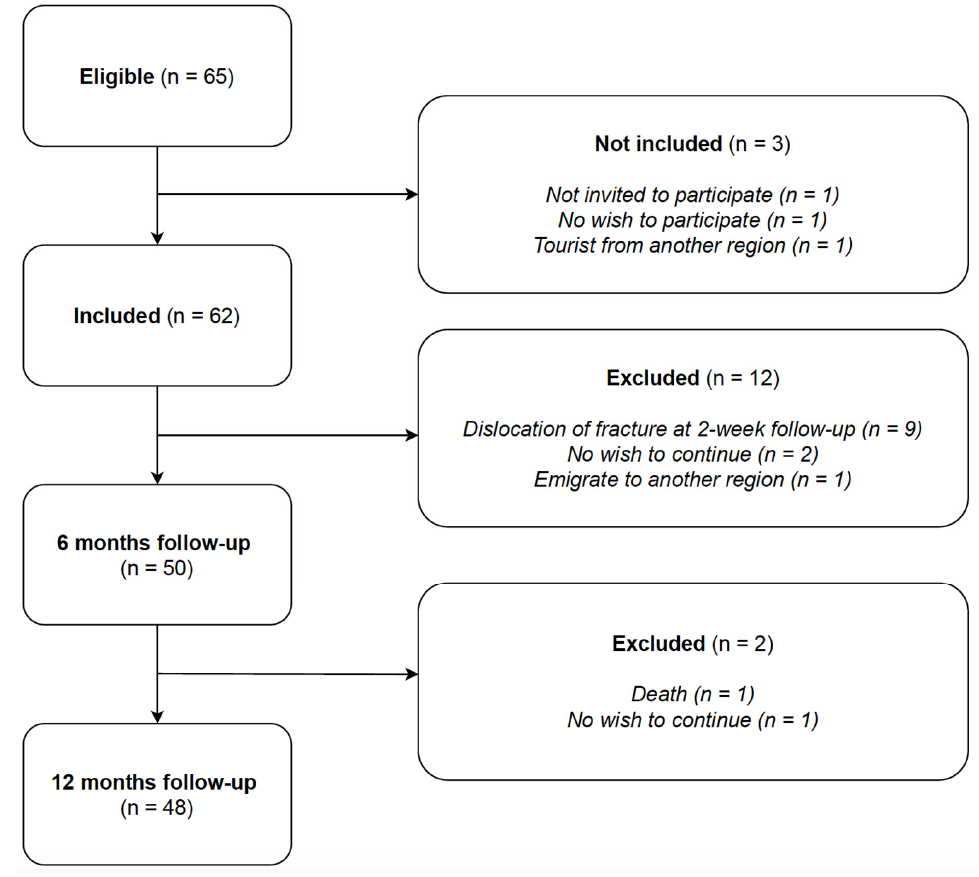
Figure 1. CONSORT Flowchart.